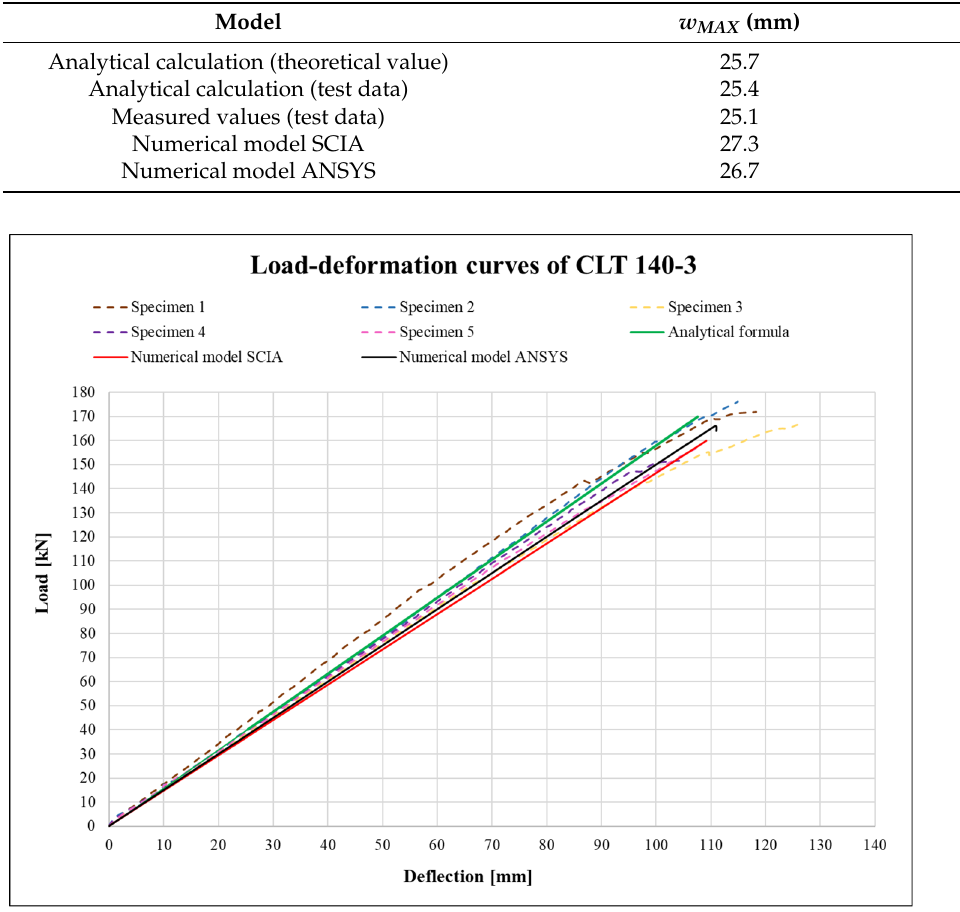
Figure 12. Load–deformation curves of CLT